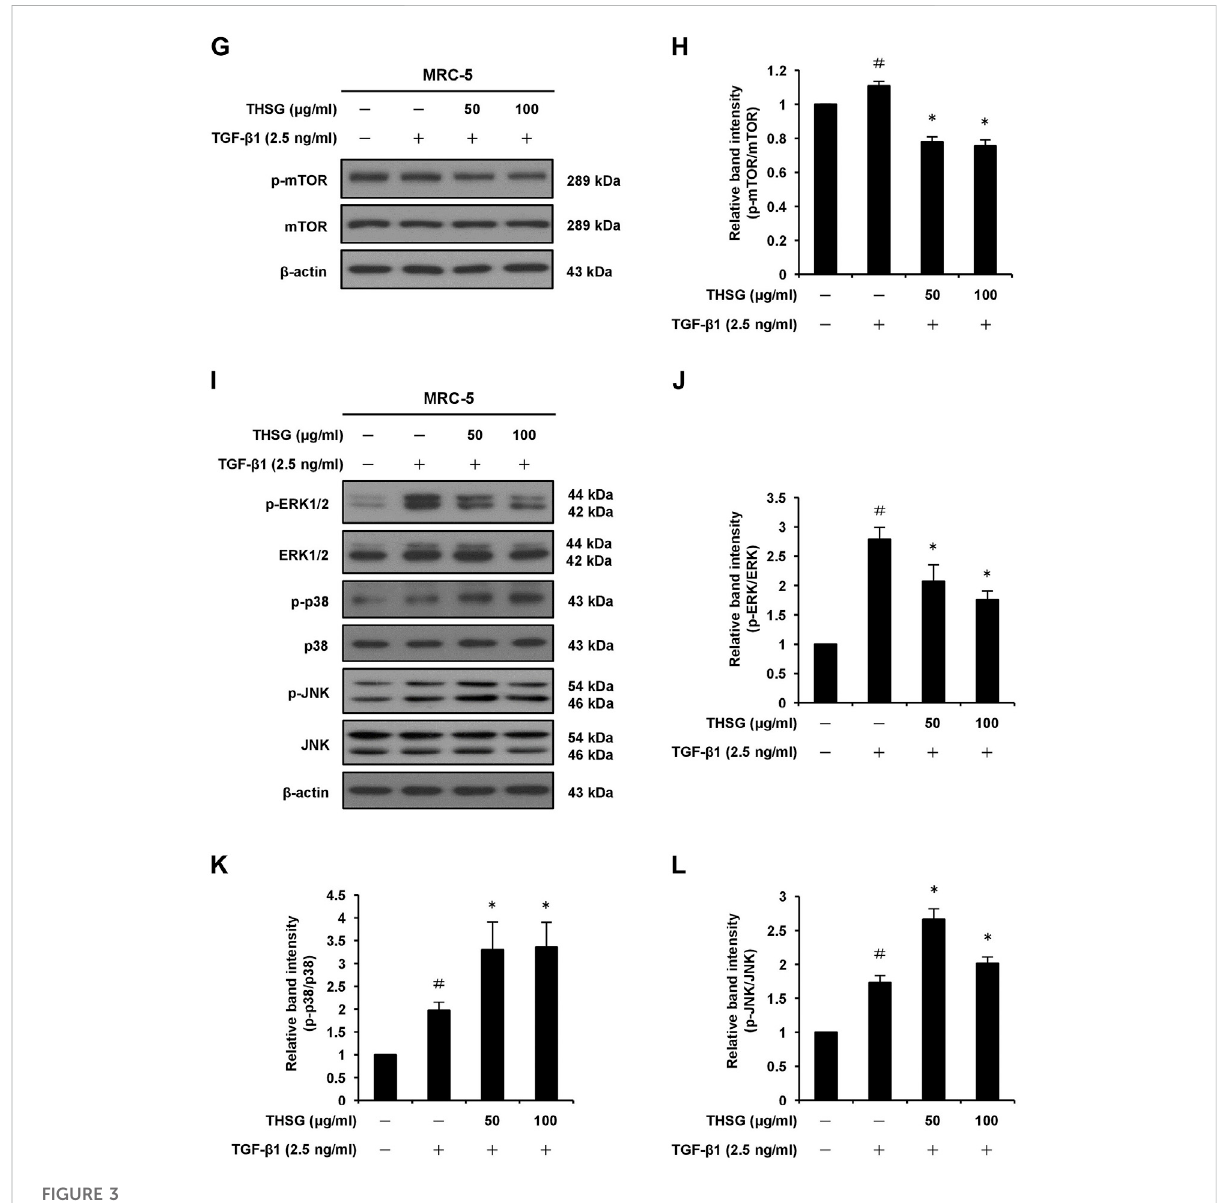
Supplementary Figures S1A,B, Western blot analysis and quantative results showed that the protein level of the epithelial phenotype marker E-cadherin was signi fi cantly decreased after stimulation of 5 ng/ml TGF- β 1 for 48 h, while pretreatment with 100 μ g/ml of THSG for 2 h profoundly increased the expression of E-cadherin in A549 cells. In contrast, TGF- β 1 treatment upregulated the protein levels of the mesenchymal phenotype markers N-cadherin and fi bronectin compared with the untreated cells. In cells pretreated with THSG, the expression levels